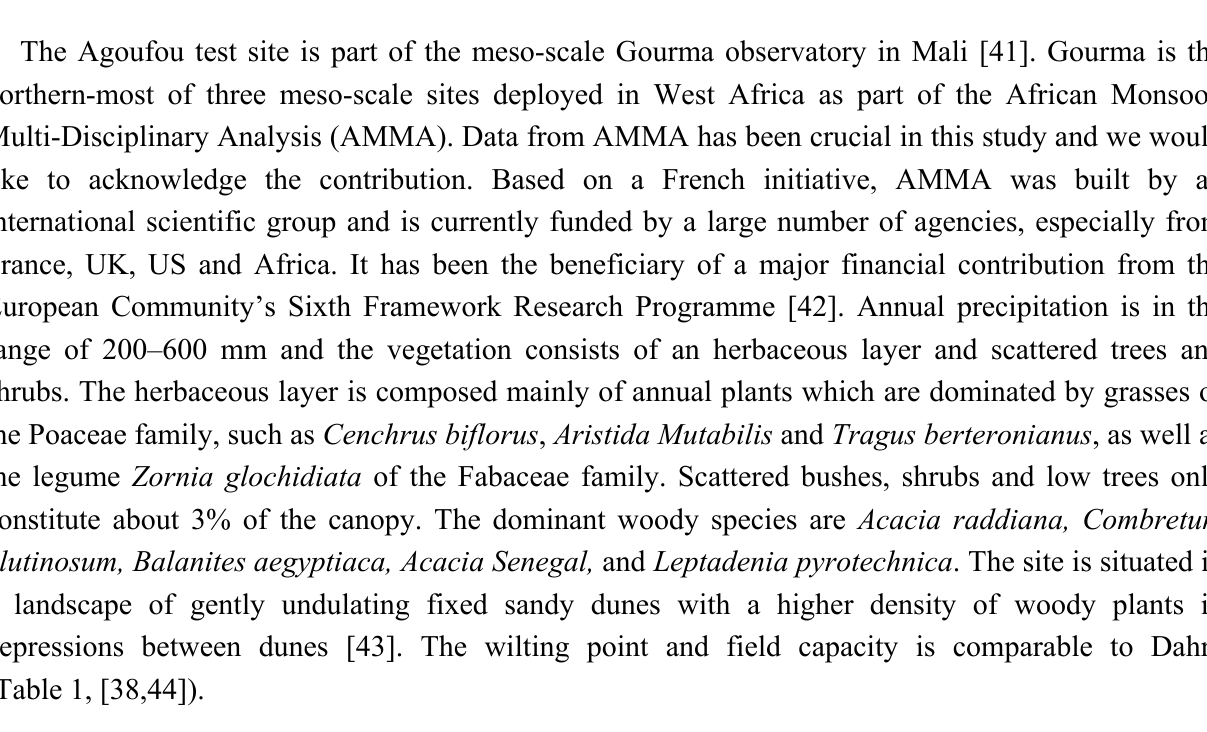
Table 1. Rainfall, soil and vegetation characteristics as published in the noted references, where more extensive descriptions of the sites can also be